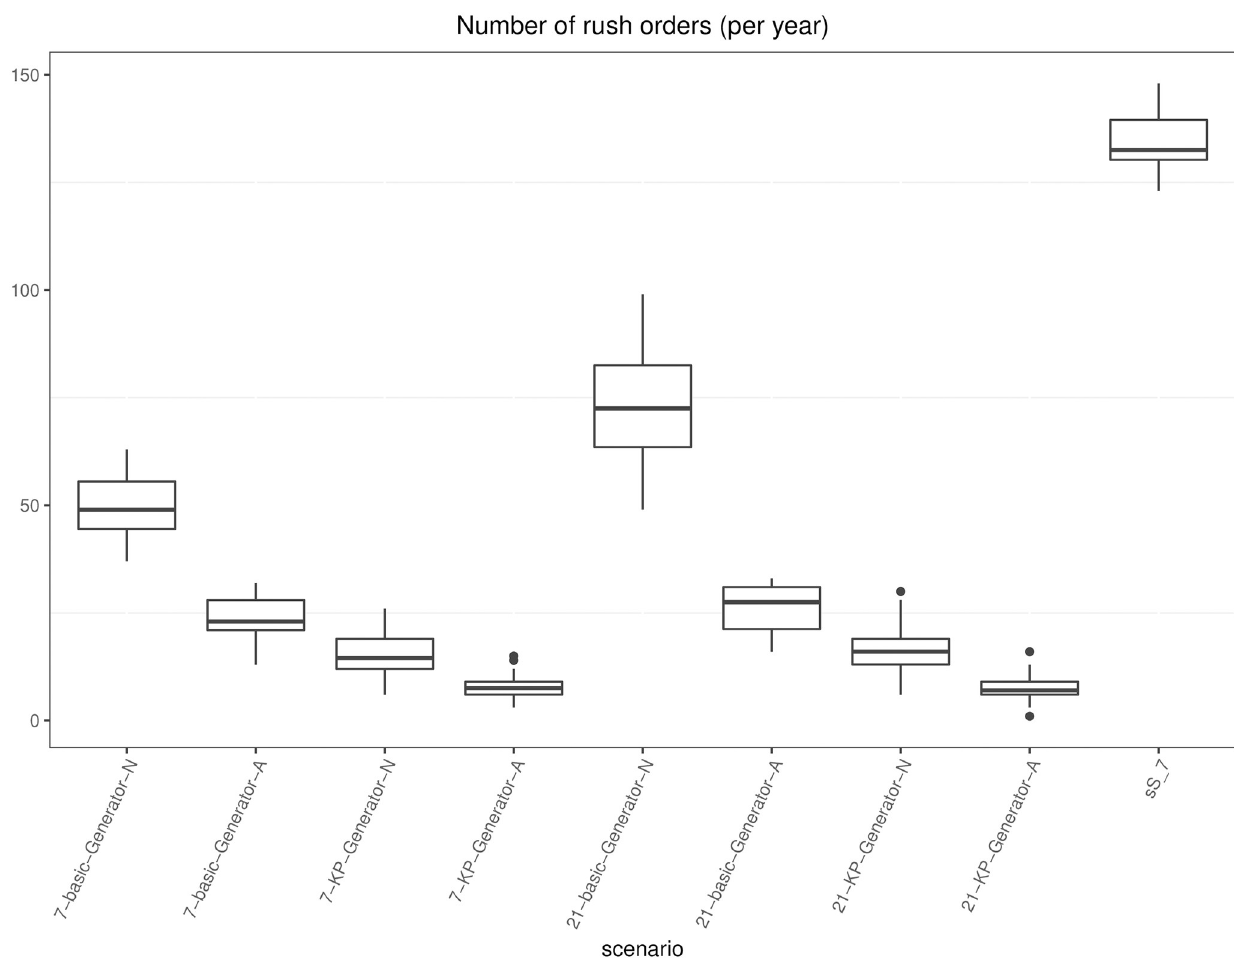
Fig 6. Boxplots of the number of rush orders. Each boxplot shows the results of 30 instances. Policy names refer to the ω , safety stock option (basic or knapsack), demand forecasting option (Generator), and aware (A) or not aware (N)